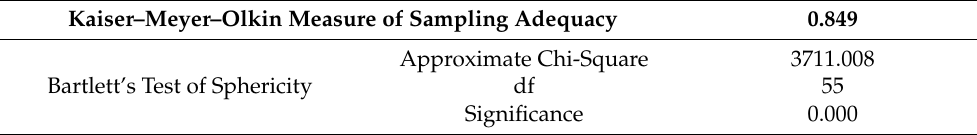
Table 3. Kaiser–Meyer–Olkin (KMO) and Bartlett’s